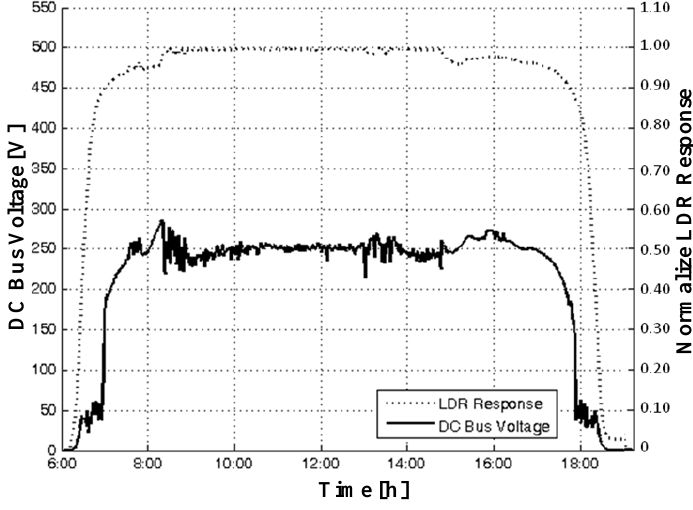
Figure 8. Fuzzy controller performance regarding the DC bus voltage